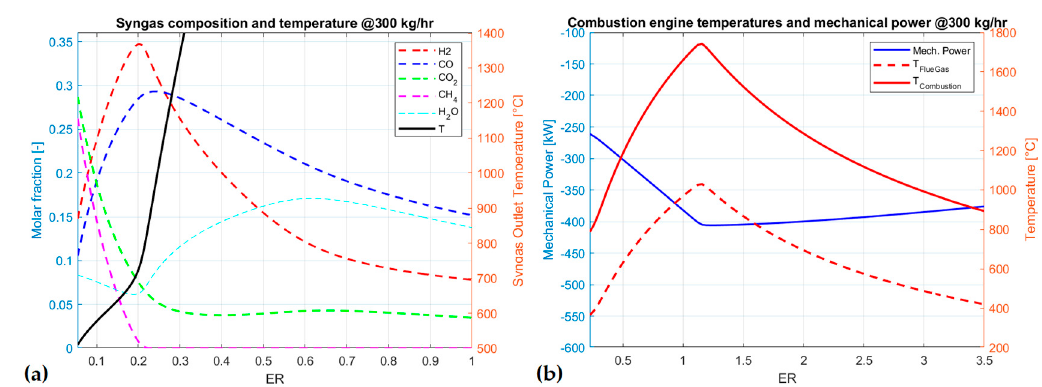
Figure 7. ( a ) Syngas composition and temperature as a function of the gasification ER; ( b ) mechanical power and gas engine temperatures as a function of the combustion equivalence ration (ER) (@ 300 kg/hr of solid wastes).